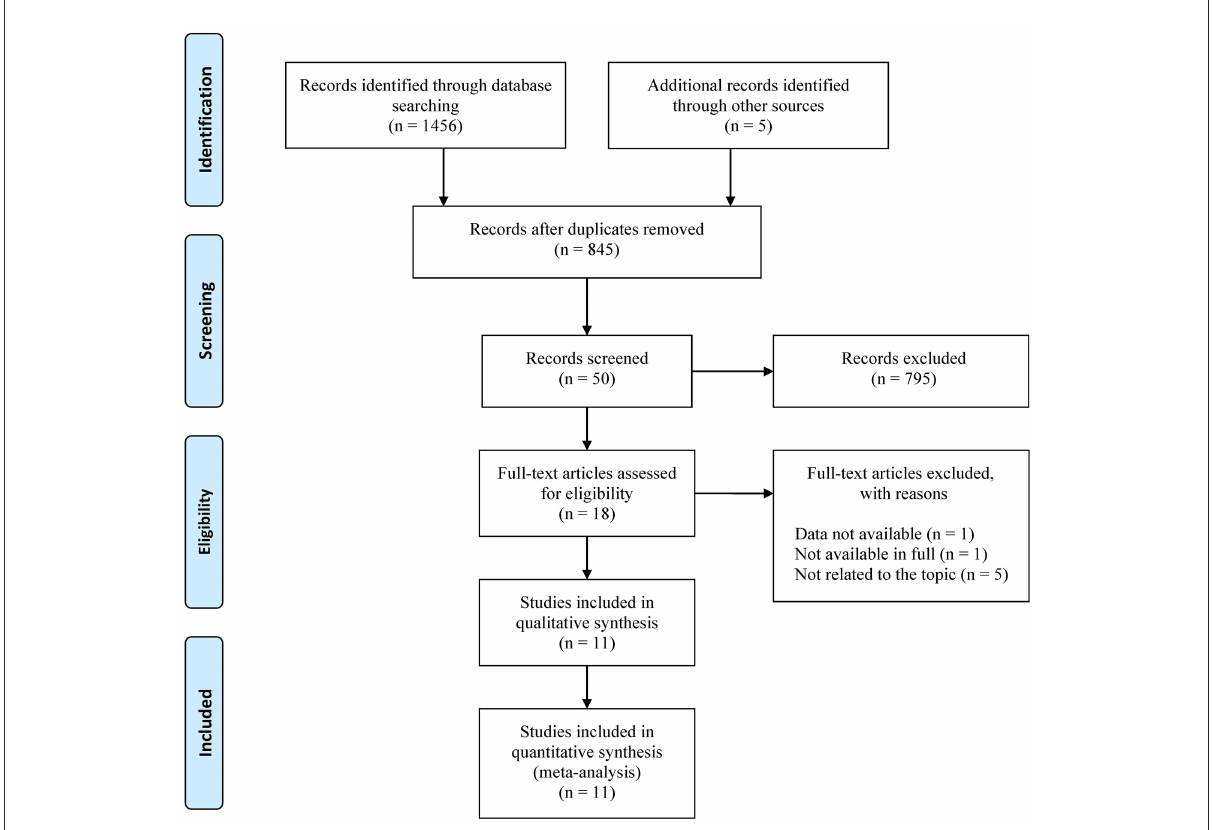
FIGURE1 Flowchart for the systematic literature